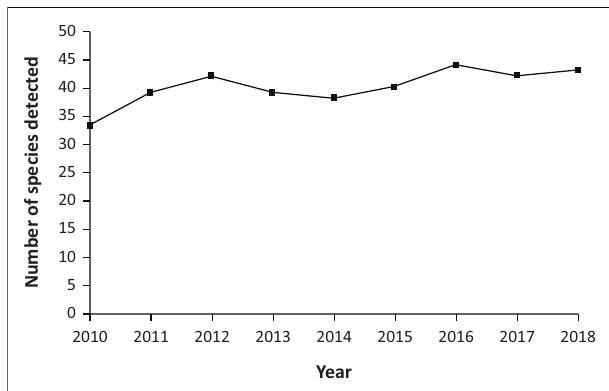
FIGURE 2: Number of species detected per year by formal point count surveys in the Mariarano study area’s forest